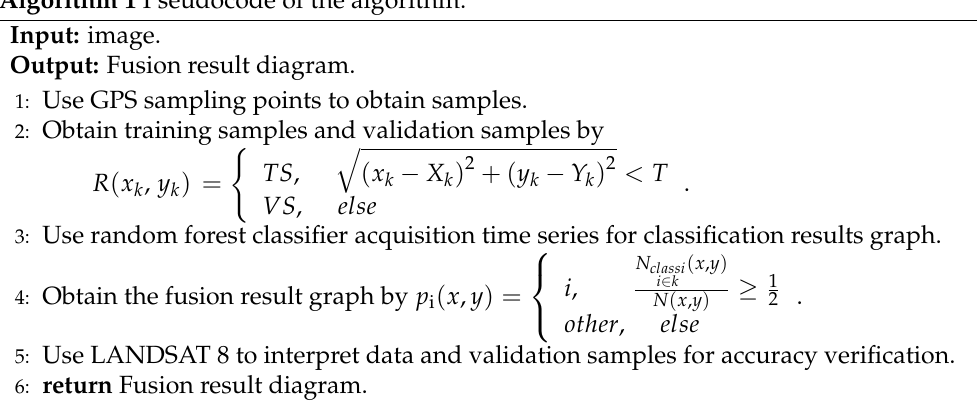
Algorithm 1 Pseudocode of the